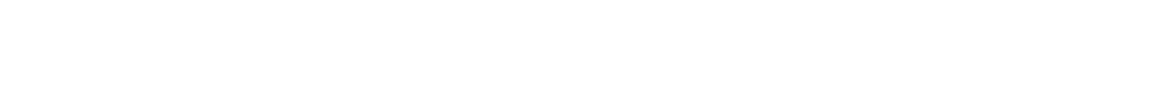
Frontiers in Endocrinology | Neuroendocrine